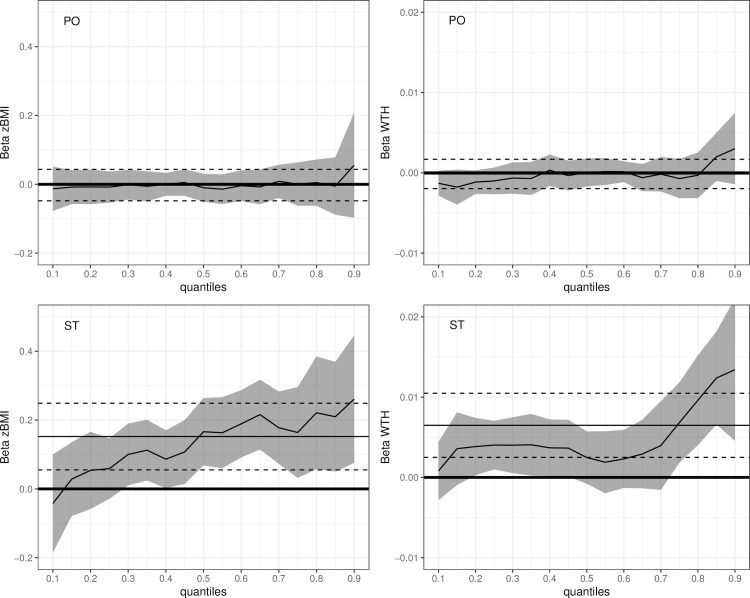
Plotted beta estimates of association between time playing outside (PO) and screen time (ST) between 3 to 6 years with anthropometrics (BMI z-score and waist-to-height ratio, WTH) at 6 years per percentile, calculated by quantile regression.Horizontal lines indicated estimates from linear regression model and 95% CI (dashed lines); grey area indicate 95% CI of each percentile’s estimates. Quantile regression models were adjusted for baseline anthropometrics, sex, country, intervention type, BMI of mother before birth and mutually adjusted for ST and PO.